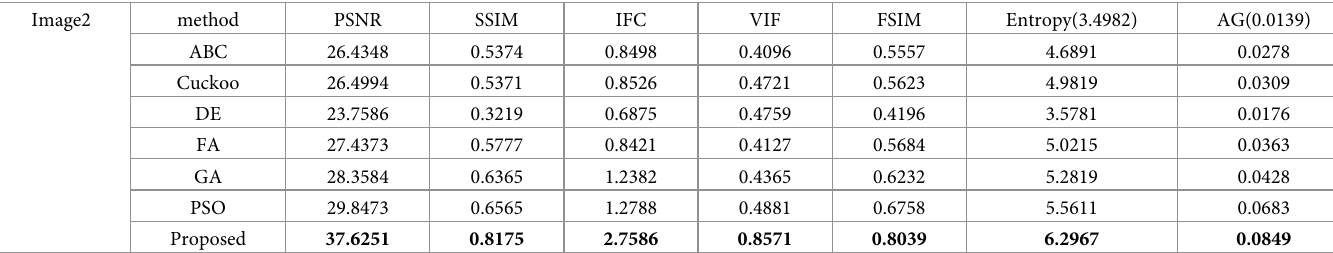
Table 6. The performance evaluation of various image contrast enhancement approaches using test images 2.